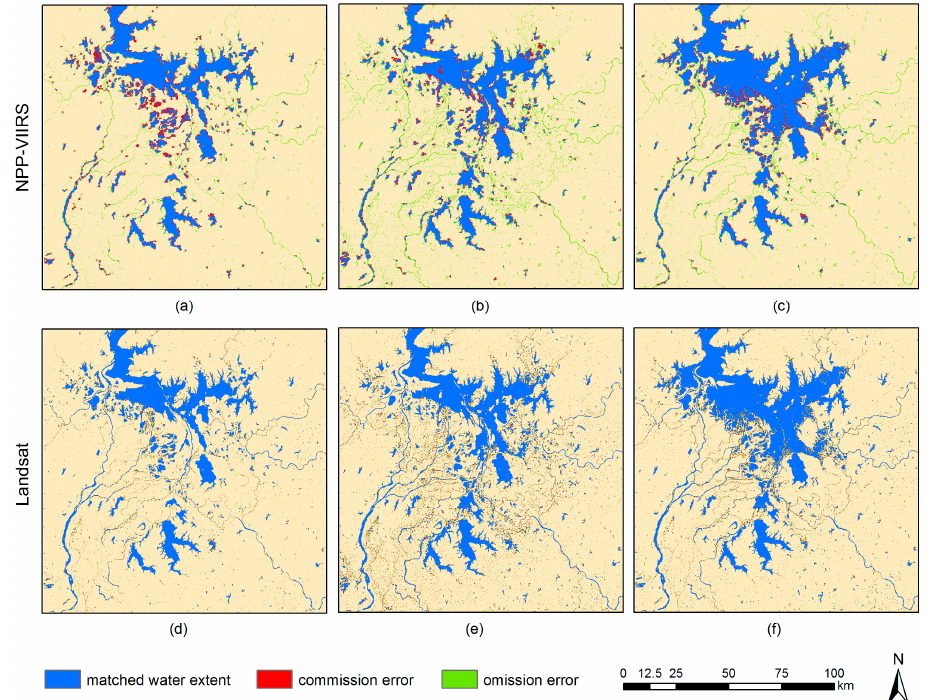
Figure 8. Validation results of subpixel mapping of Poyang Lake ( a ) from the NPP–VIIRS on 5 October 2013; ( b ) from the NPP–VIIRS on 1 May 2014; ( c ) from the NPP–VIIRS on 8 October 2014; ( d ) from the Landsat on 5 October 2013; ( e ) from the Landsat on 1 May 2014; ( f ) from the Landsat on 8 October 2014.